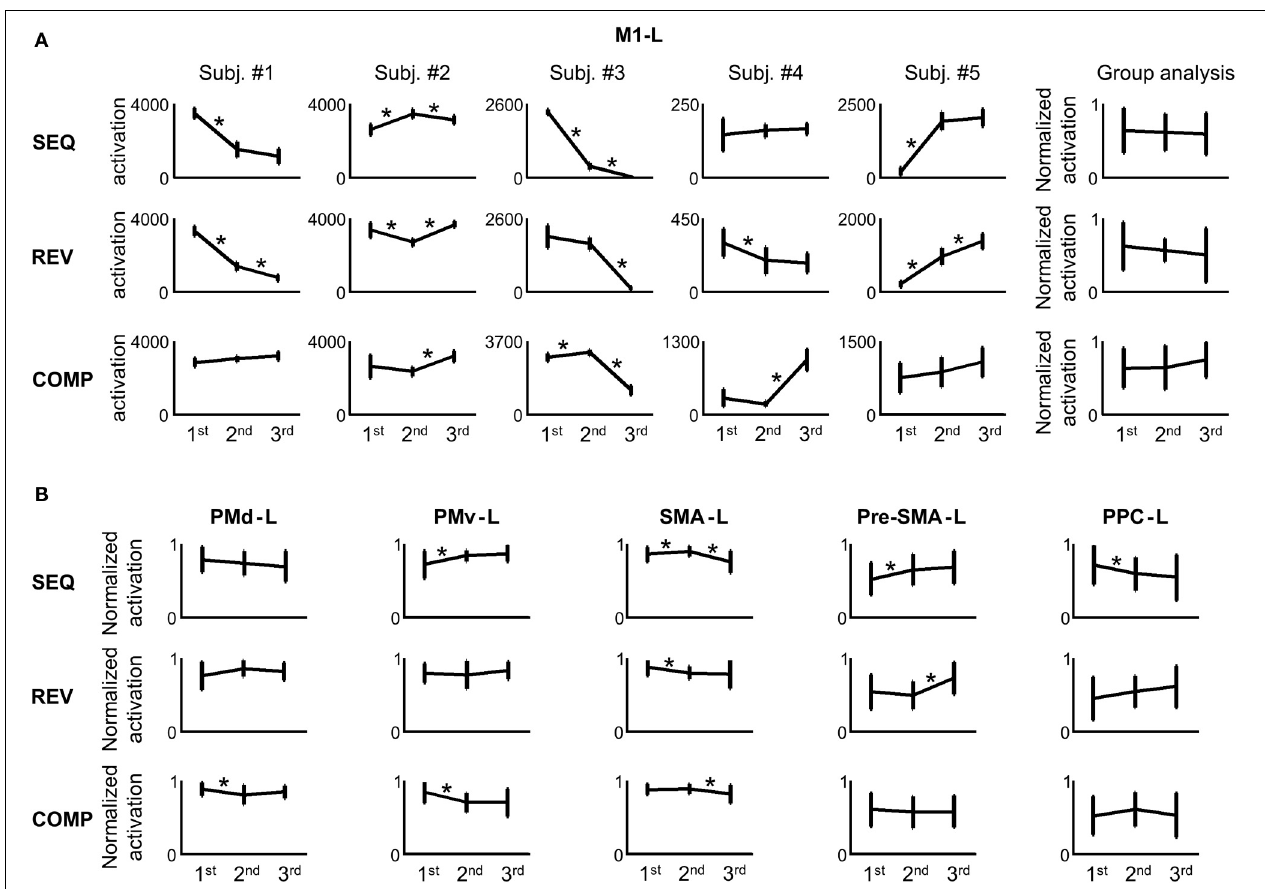
FIGURE 6 | No correlation between the amount of activation in the different regions of interest (ROIs) and the amount of practice. (A) For each repetition, the M1-L activation was estimated. The error bars represent error across repetitions. The rightmost panel in each training condition presents the group analysis (the normalized activations of all the subjects in